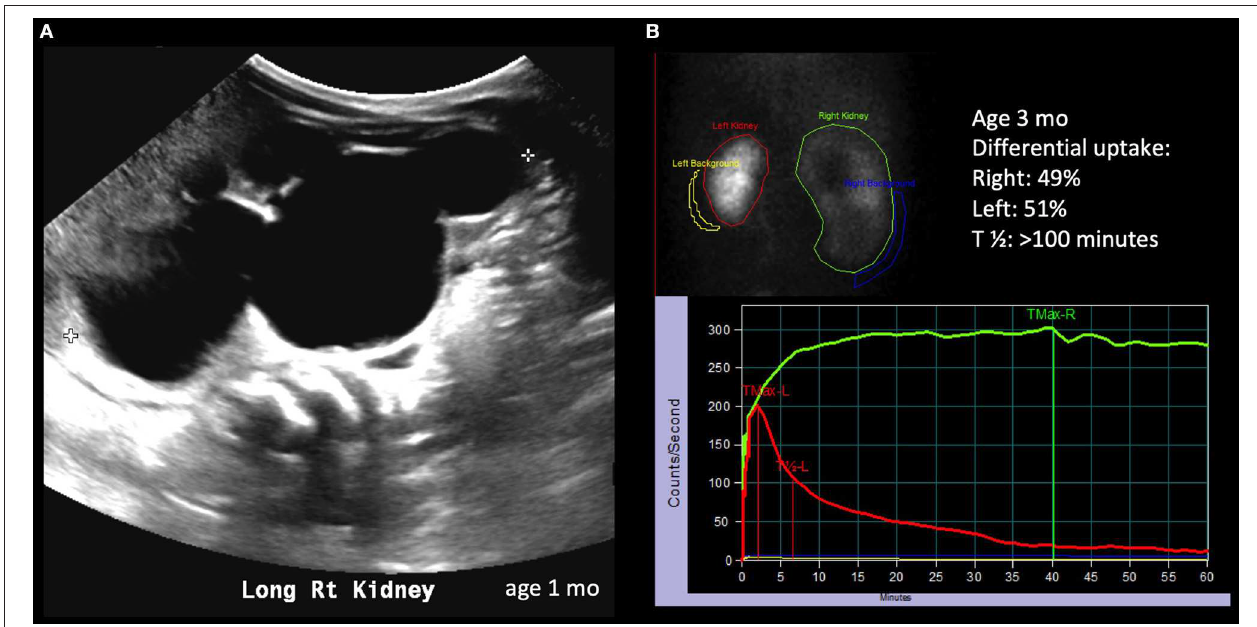
FIGURE 2 | Radiological history of an infant with severe hydronephrosis secondary to significant UPJ obstruction. (A) Ultrasound showing SFU grade 4 hydronephrosis on postnatal imaging. (B) Diuretic renogram showing symmetrical uptake; unlike the case described in Figure 1 , the drainage curve of the right kidney does not show any drainage, even after diuretic